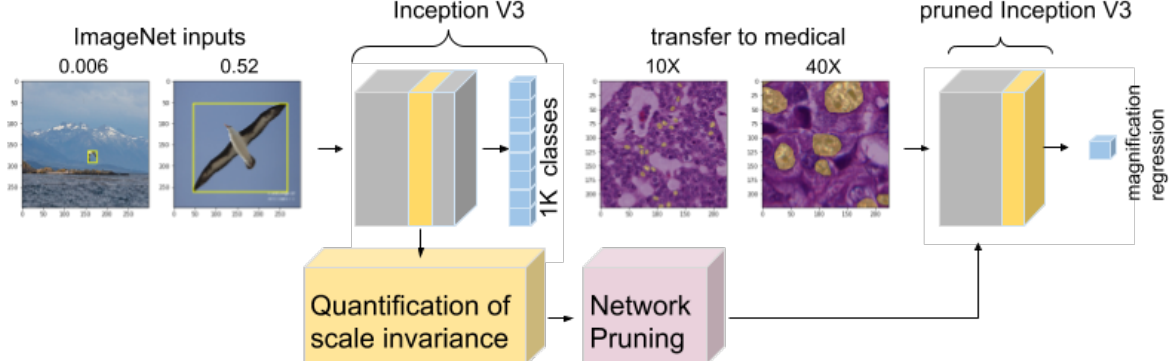
Figure 3. Pipeline of scale quantification in ImageNet pretrained networks and consequent network pruning for better transfer to the medical domain. The bounding boxes for the image of the ImageNet class albatross and the segmentation masks for the ERBCa+ inputs are overlaid in yellow on the images. The bounding box ratios r are reported on top of the ImageNet inputs. ERBCa+ images are shown at magnifications 10X and 40X. The layer evidenced in yellow is the most informative about scale according to our quantification of scale invariance. The pruned network drops the layers after this for solving the medical task. Best seen on